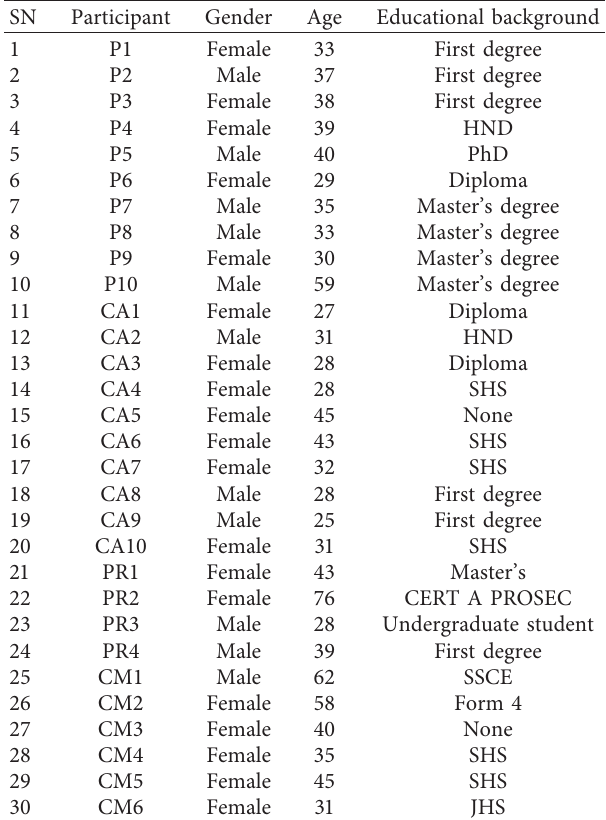
Table 1: Bio-data of study